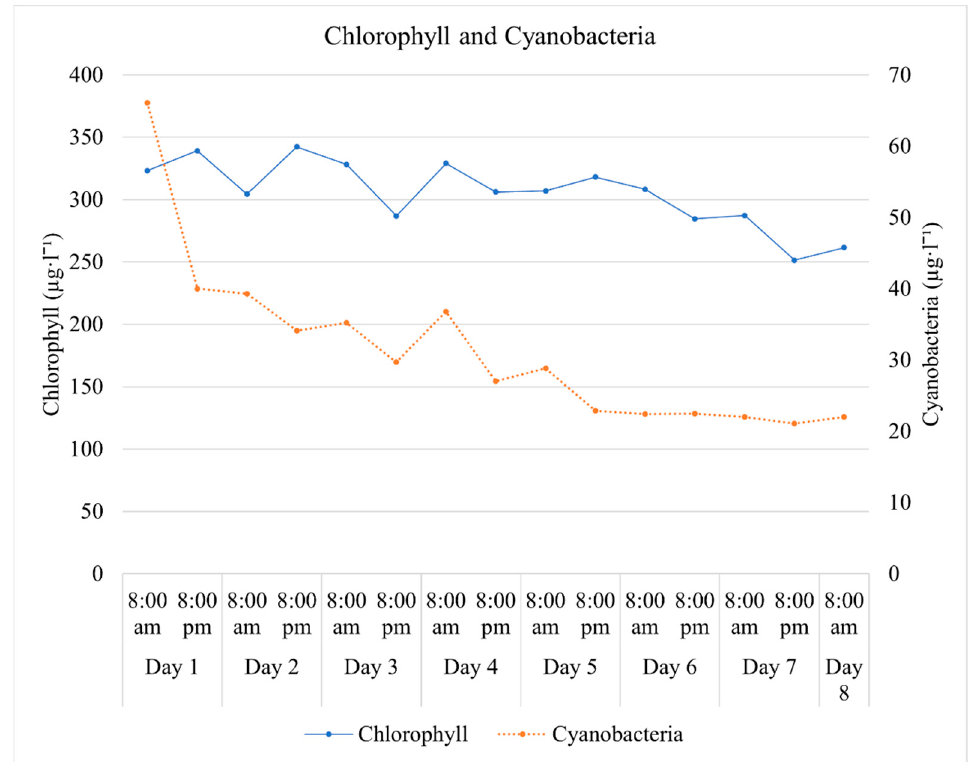
Figure 5. Algal chlorophyll and cyanobacteria concentration in the aquaculture wastewater measured at 8:00 am and 8:00 pm during the eight days of the experiment. N= night, D= day. Samples of biofilm attached to the internal surface of the tanks were observed with a microscope. The genera identified are indicated in Table 1. Table 1. Genera of microalgae identified in samples of biofilm and phytoplankton built in the internal surface of the tanks.